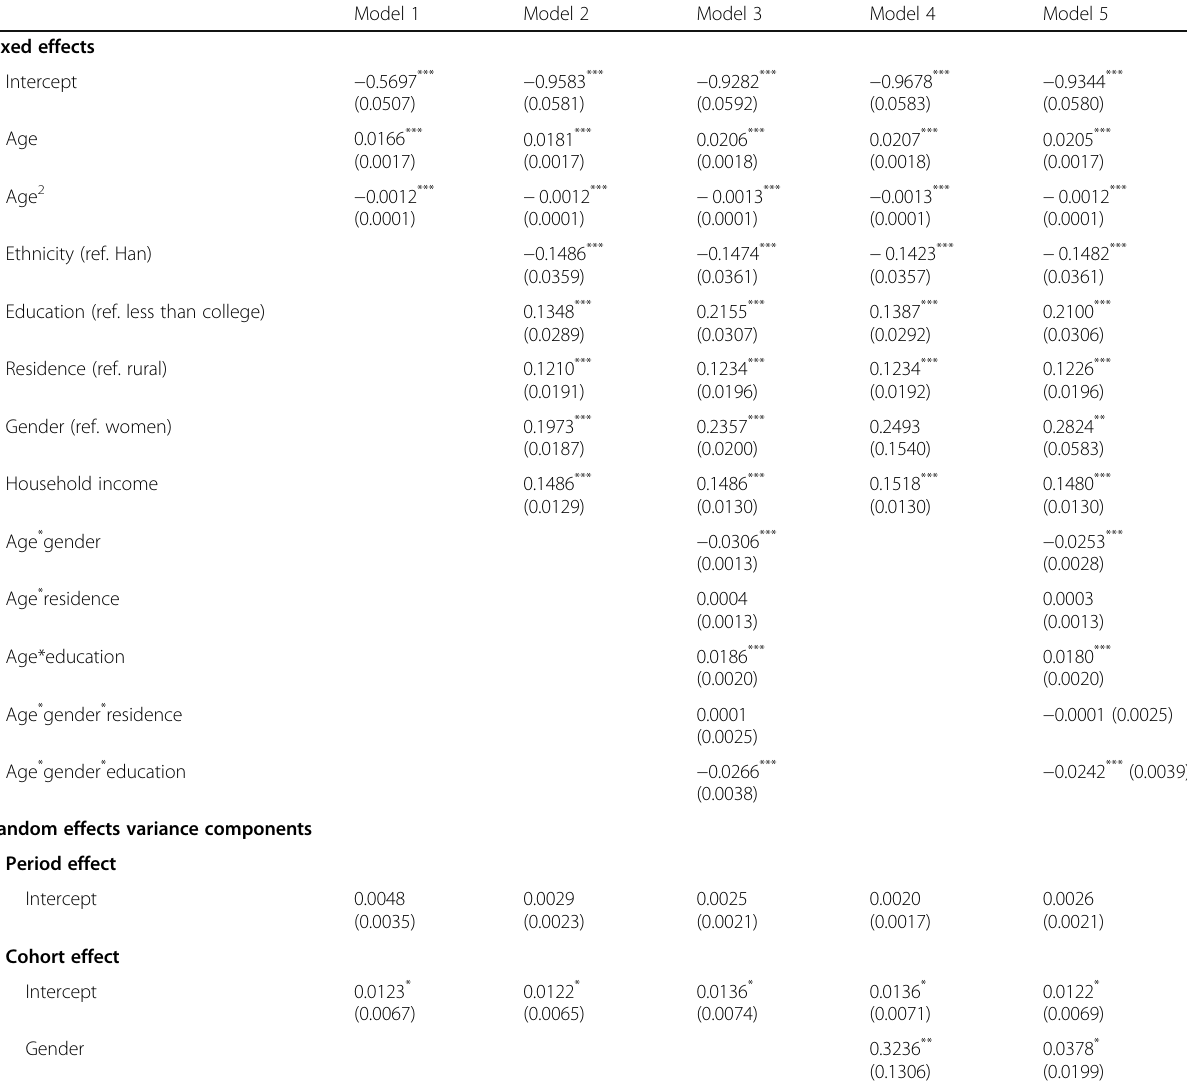
Table 3 Estimates from HAPC-CCREM of age, period and cohort effects on overweight among Chinese adults, CGSS2008 –